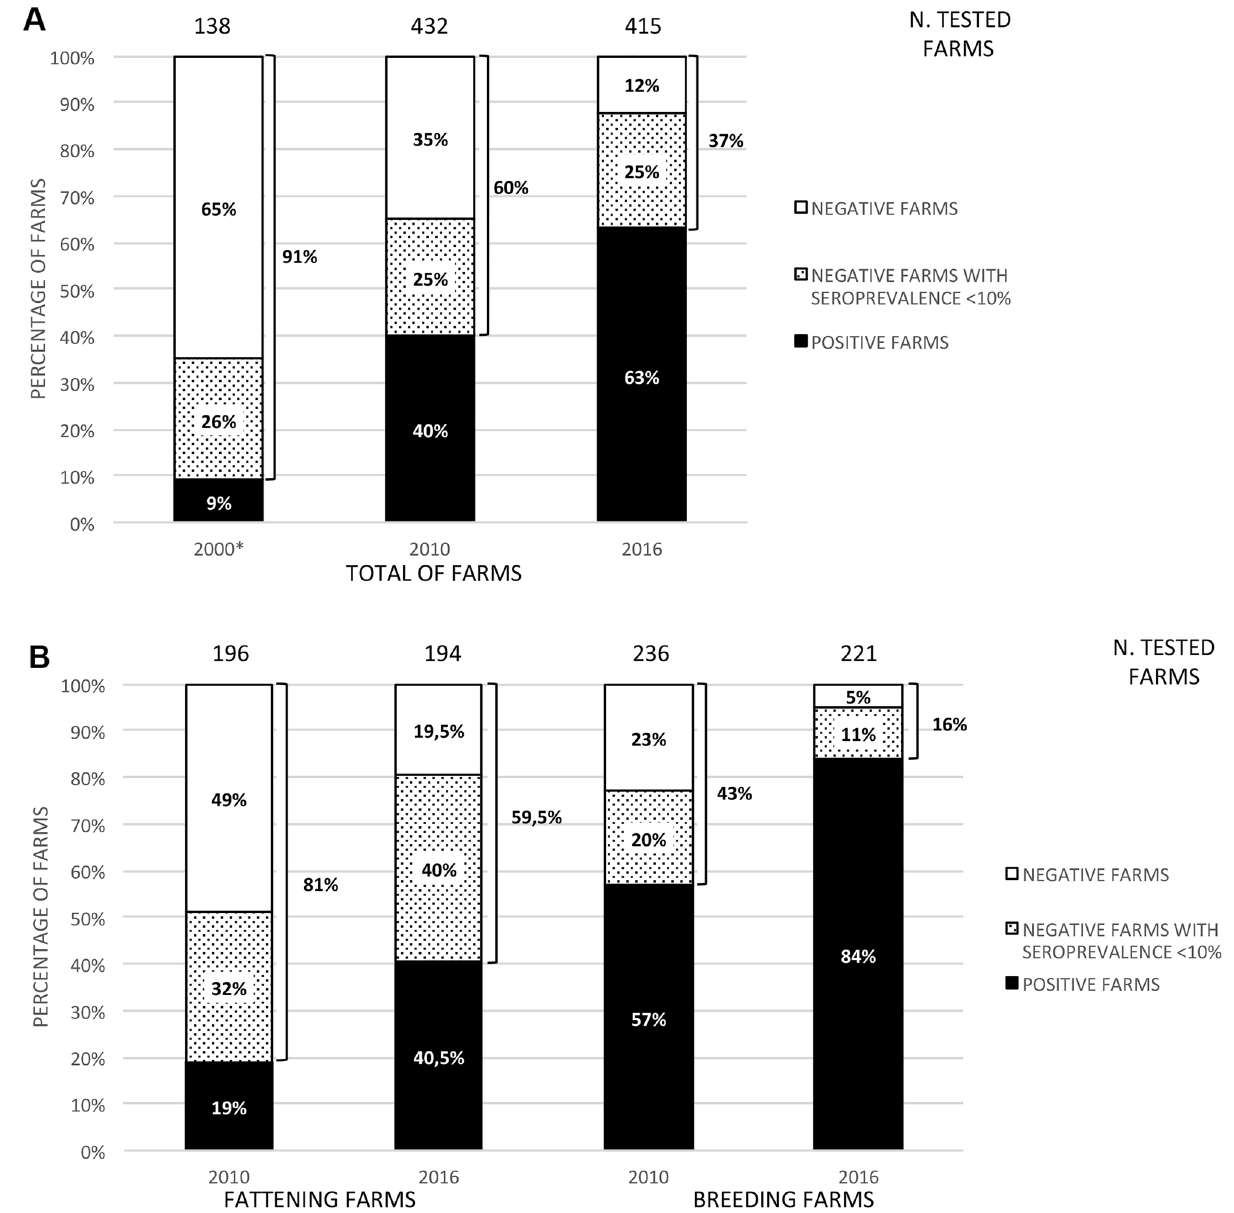
Figure 5. Serosurvey of pig herds in Northern Italy. Graphs compare seroprevalence percentage obtained during serosurvey of swine farms of Lombardy and Emilia-Romagna in 2016 with data of 2010 and 2000. Farms were considered as positive (black) if percentage of seropositive sera was higher than 10% and negative with lower percentage of seropositivity. Negatives include farms with seroprevalence equal to 0 (white) and with seroprevalence lower than 10% (dotted). ( A ) total of farms considered.( B ) herds divided between Fattening and Breeding. Only 2016 and 2010 data considered. Differences between data were statistically validated with one-sided Fisher’s exact test and p value obtained for every couples compared was lower than 0.001. *, in 2000 29